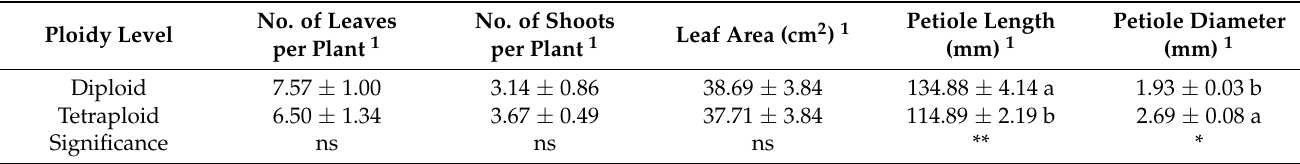
1 Data represent mean ± SE. Different lowercase letters indicate significant differences ( p < 0.05; Duncan’s multiple range test; * p < 0.05; ** p < 0.01). ns,